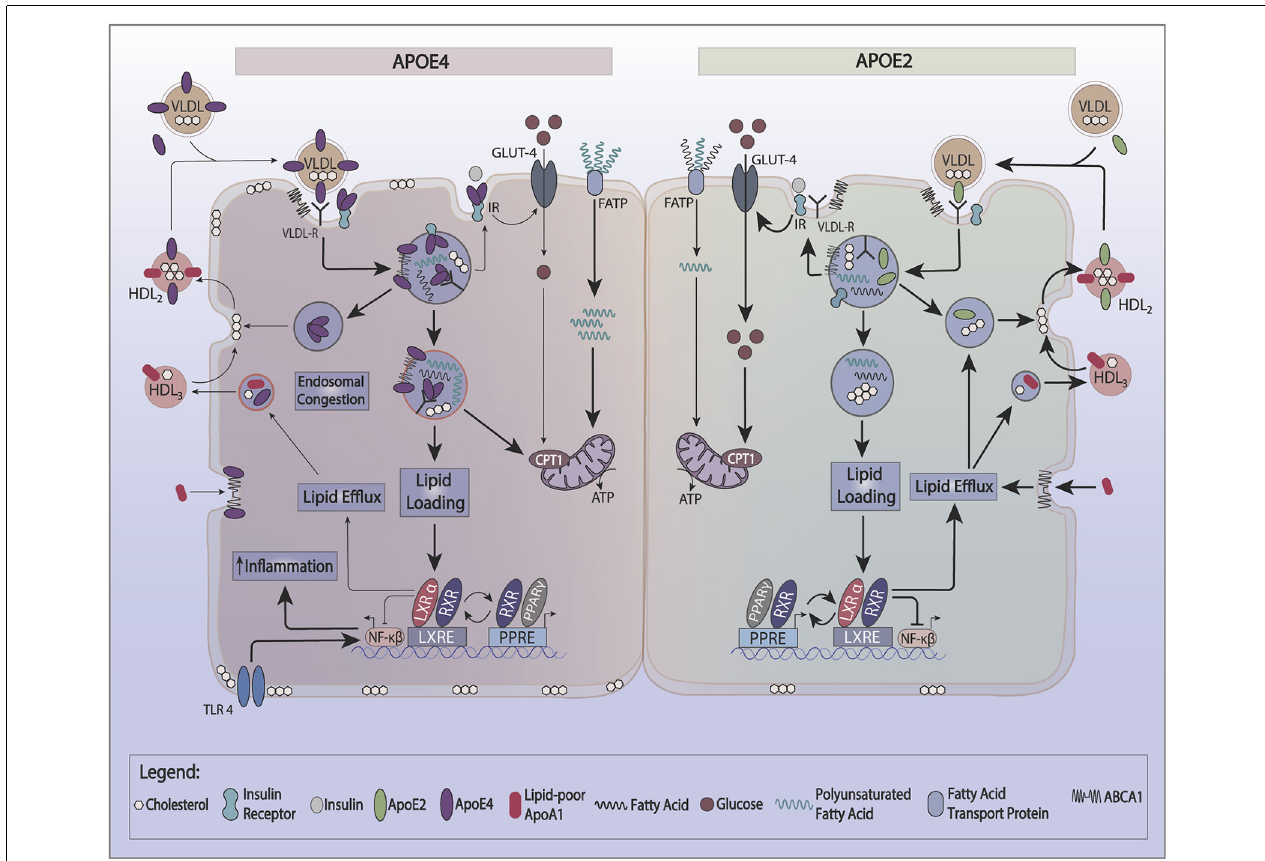
FIGURE 1 | Effect of apoE recycling and aggregation on glucose and lipid metabolism. ApoE recycling controls the expression of several cell surface proteins, such as the insulin receptor (IR), ATP binding cassette 1 (ABCA1), or lipoprotein receptor-related protein 1 (LRP-1). The formation of smaller HDL3 by ABCA1 stimulates apoE recycling. In the circulation, apoE exchanges between HDL and VLDL. Upon lipid loading, the expression of apoE, ABCA1, and ABCG1 is induced via the PPAR/LXR/RXR system to facilitate lipid storage or oxidation and formation of HDL. ApoE4 is prone to aggregate in endosomes trapping interacting proteins such as IR and ABCA1. ApoE4’s switches the cellular energy preference from glucose to polyunsaturated fatty acids, and associates with lower ABCA1 activity and greater cell membrane cholesterol. Greater cell membrane cholesterol enhances TLR4 signaling and activates the inflammasome. ApoE4 also decreases the activation of PPAR γ contributing to lower insulin sensitivity and utilization of glucose as a source of